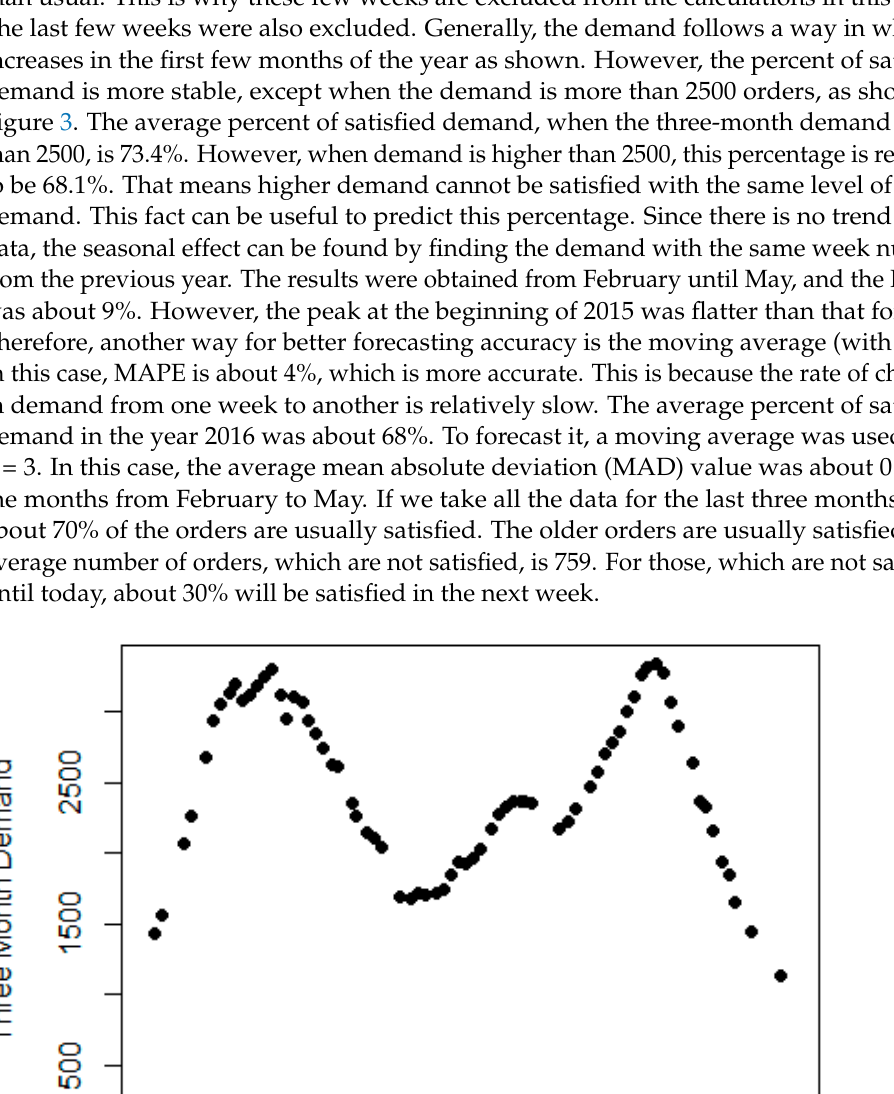
Figure 3. The effect of demand on the percentage of satisfied orders in the three-month period.